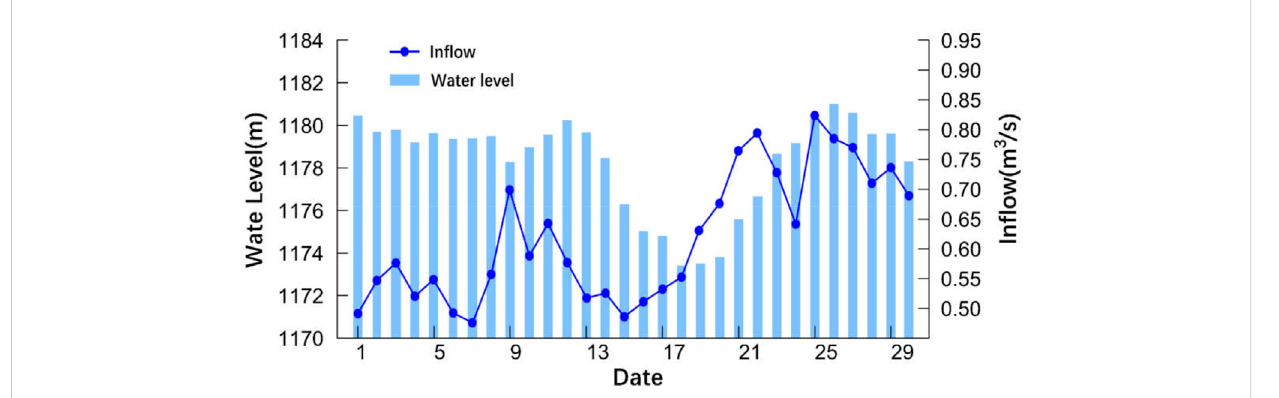
FIGURE 8 Optimal water level curve and in fl ow process.